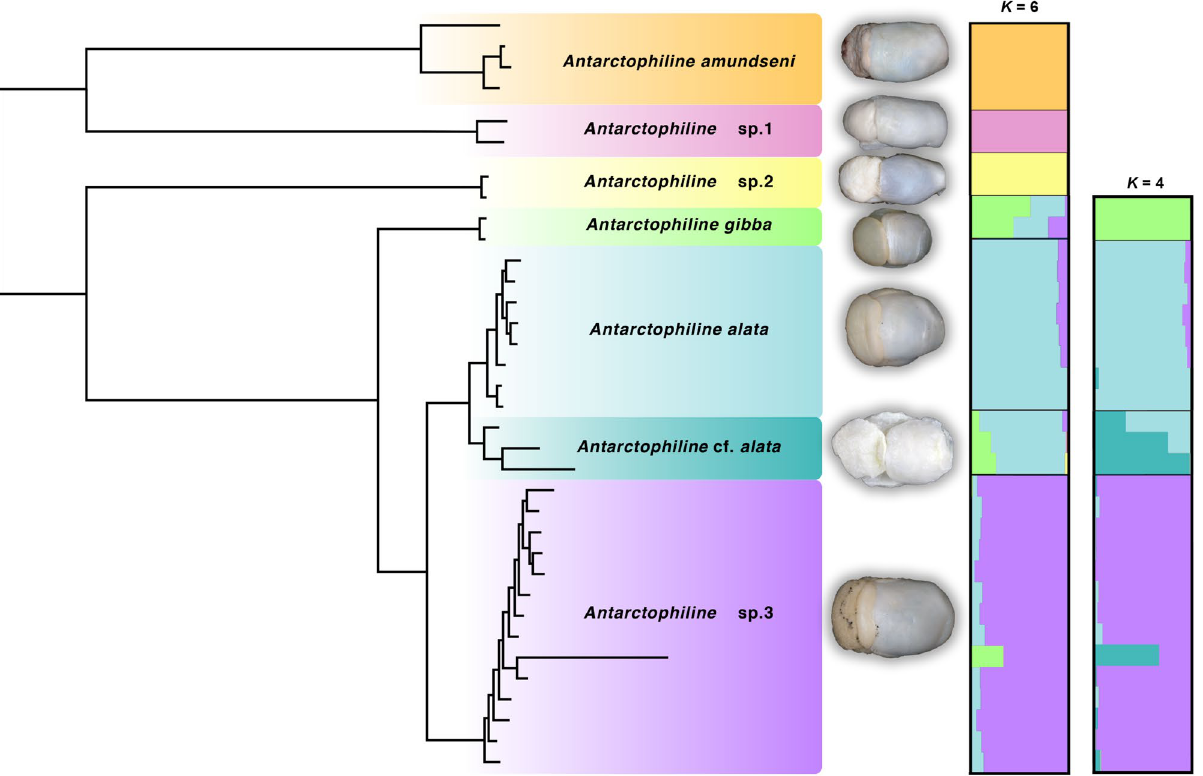
Figure 2. Phylogram of antarctophilinids based on Matrix 2 (left) and STRU CTU RE plots (right), showing the posterior probability for individual assignments of samples to different genetic clusters. Both plots show the result for the most likely number of genetic clusters for Matrix 2 ( K = 6) and Matrix 3 ( K = 4). Dorsal pics of preserved type specimens for each cluster are also depicted.